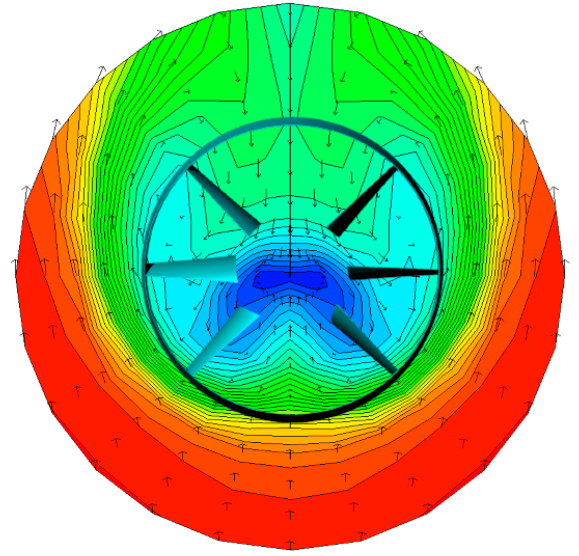
Figure 10. Determination of ring stator diameter considering wake distribution.